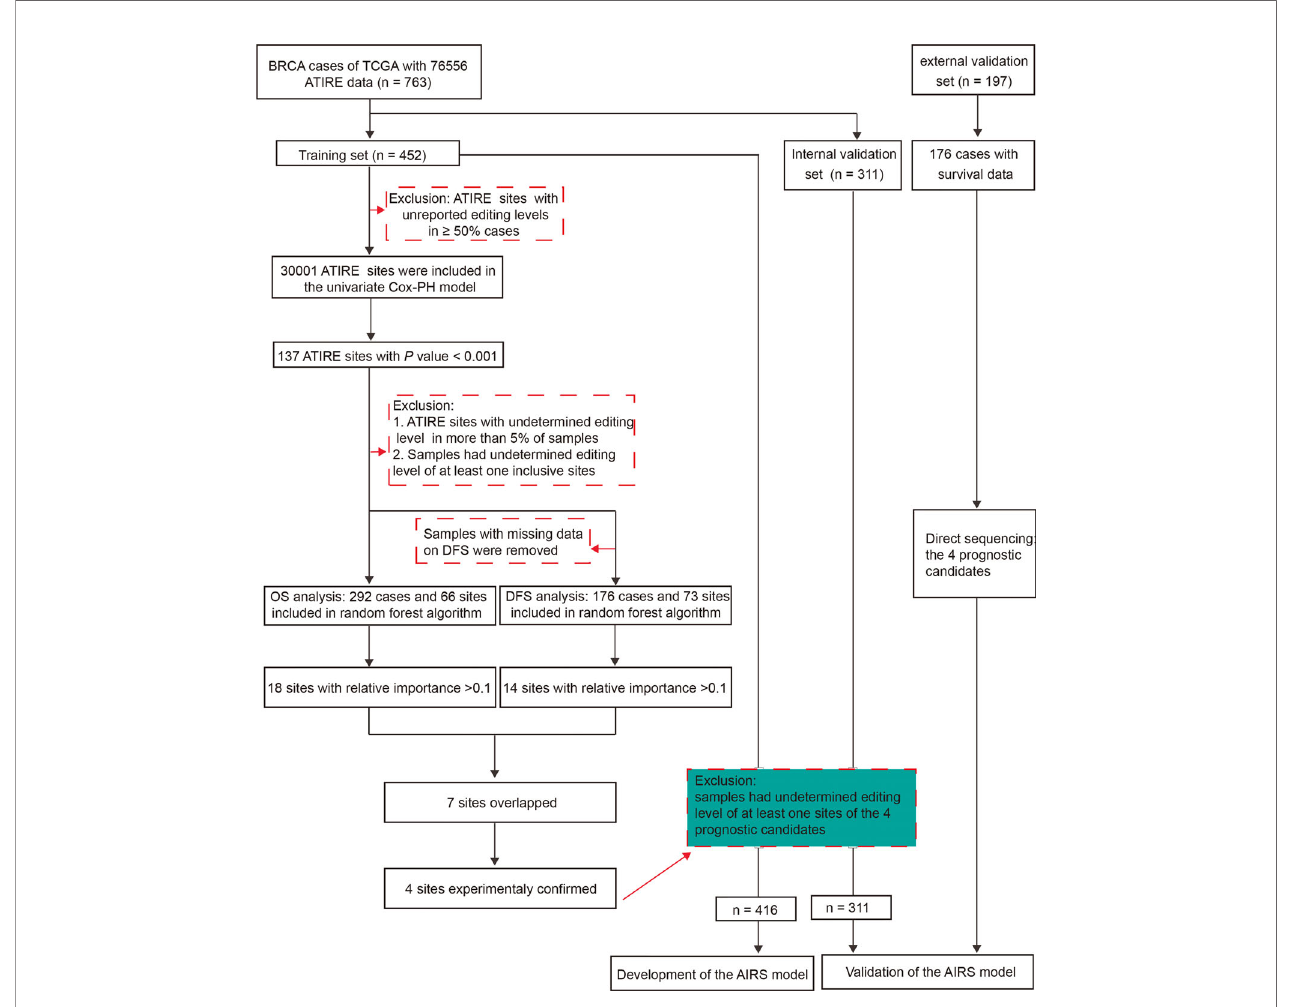
FIGURE 1 | The work fl ow of generation of an AIRS model for BRCA OS and DFS. AIRS, adenosine-to-inosine RNA editing risk score; BRCA, breast cancer; OS, overall survival; DFS, disease-free